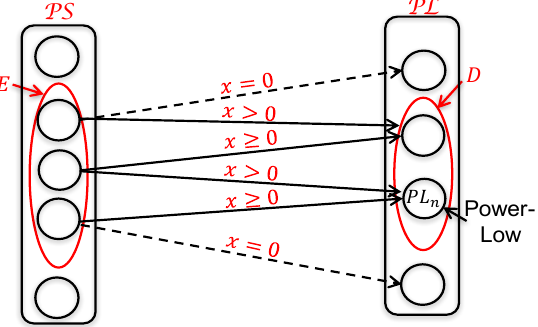
Figure 8. Illustration of sets A and B of power sources and power loads, respectively, which are reachable from PS m by alternating paths.